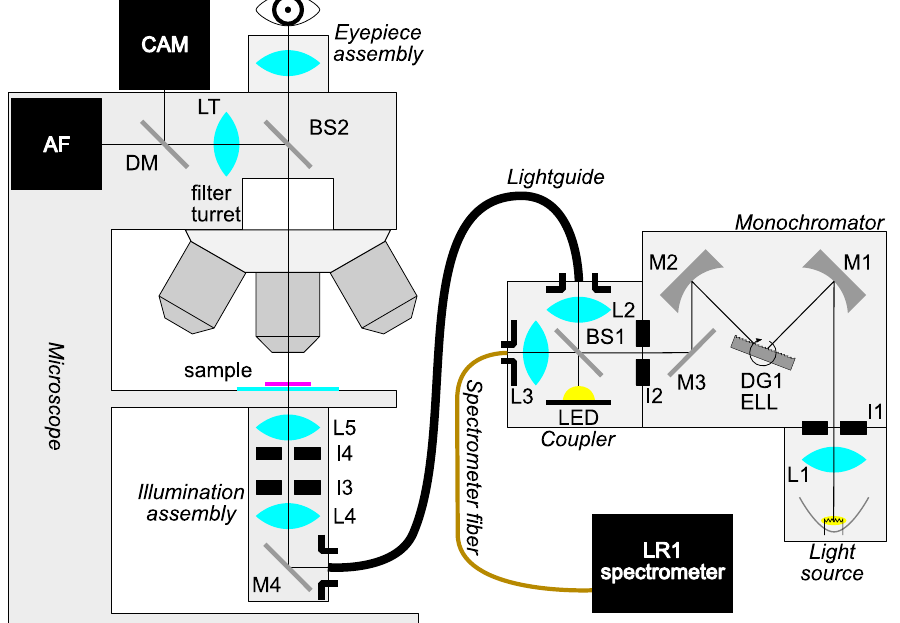
Figure 1. Outline of the hyperspectral microscope imaging (HMI) system setup. Light from the halogen lamp is collected by a lens and passed into a Czerny-Turner-type monochromator of custom design. Monochromatic light is then directed into the coupler, where part of the light is used for online monitoring via a spectrometer. The remaining part of the light, along with light from an optional high-power white LED used for orientation, is passed through a fiber bundle light guide. Using a custom Köhler illumination assembly, light impinges on the sample. Light from the sample is collected by an objective and passes through the microscope to either eyepieces or a camera